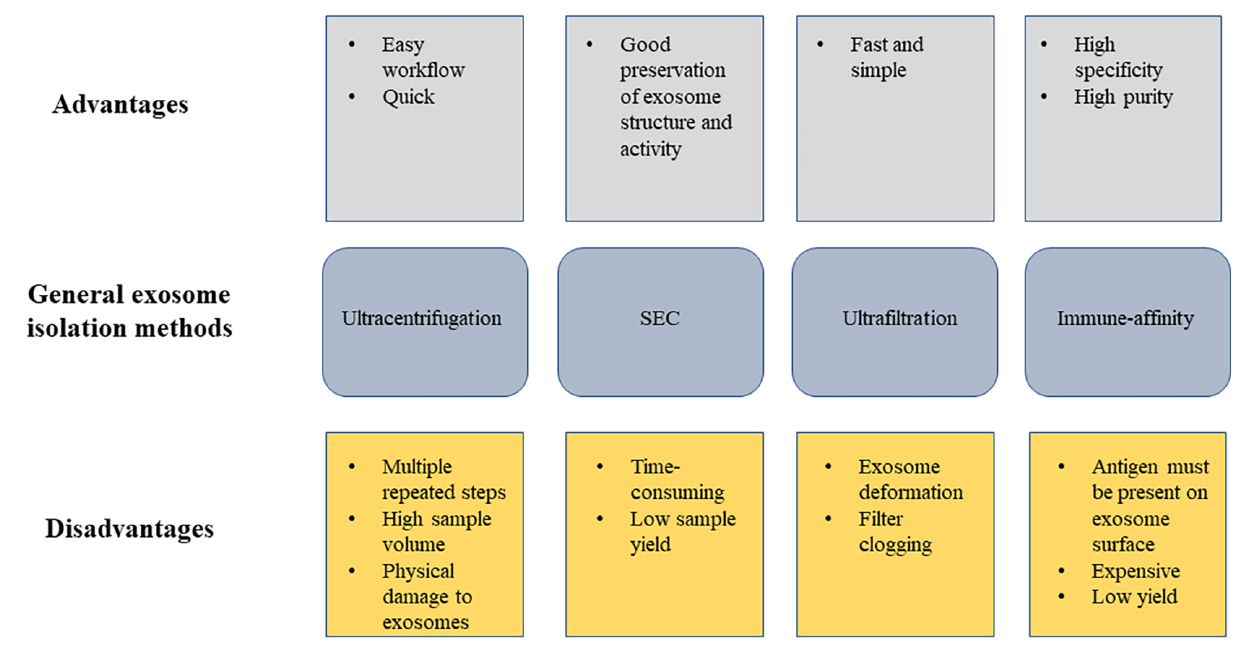
FIGURE 2 | Illustration of exosome isolation strategies in current ALS studies. This figure depicts the advantages and disadvantages of the general exosome isolation methods used in currently available ALS